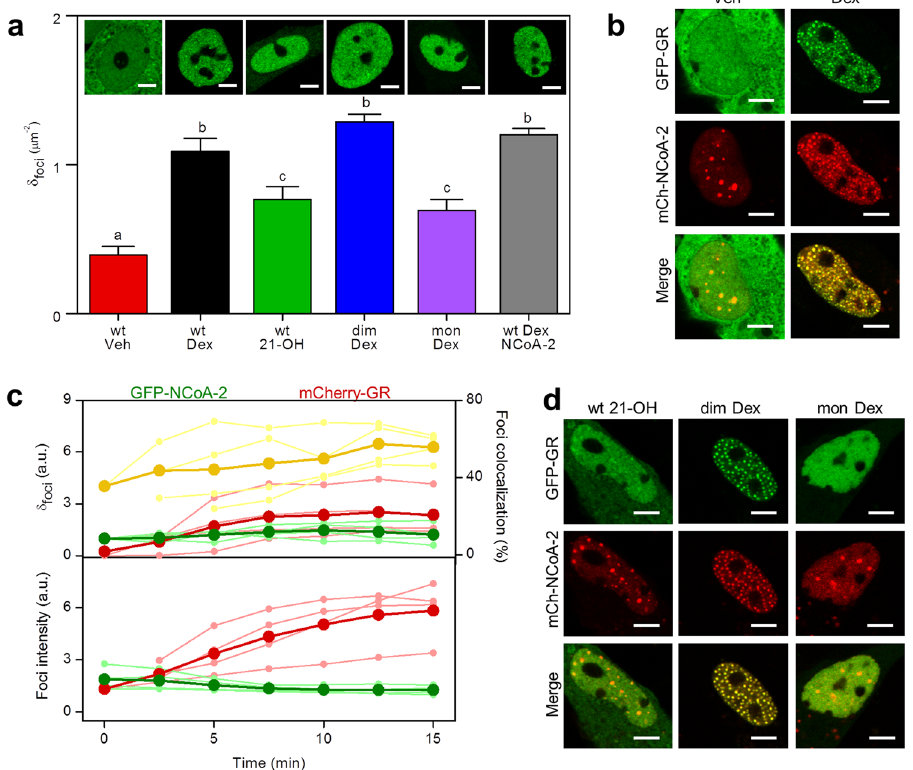
Figure 1. Activated GR and NCoA-2 redistribute to colocalized intranuclear foci. Subcellular distribution of GFP-GR and mCherry-NCoA-2 in BHK cells was analyzed upon hormone induction by using different imaging tools as indicated in Methods section. ( a ) Cells expressing GFP fused to the indicated GR variant (wild type, GRdim, GRmon) were treated with Dex, 21-OH or vehicle (Veh). NCoA-2 was co-expressed where indicated (Scale bar: 5 µ m). GR capability to form intranuclear foci was quantitatively analyzed by calculating the nuclear foci density (n = 15). Bars with the same superscript letters represent data not significantly different from each other (p < 0.05). ( b ) Subcellular distribution of GFP-GR and mCherry-NCoA-2 in untreated or Dex-stimulated cells (Scale bar: 5 µ m). ( c ) Analysis of time-lapse images of cells co-expressing GFP-NCoA-2 and mCherry-GR, within 15 min after Dex-stimulation. Different image-analyisis tools were used to calculate the relative foci density ( δ ) (upper panel); percentage of colocalized foci (upper panel, yellow line) and the relative mean intensity of foci (lower panel). Light curves represent single cell data to illustrate the cell-to-cell variability while dark curves correspond to mean values. ( d ) Representative images of cells expressing mCherry-NCoA-2 and GFP fused to the indicated GR variant (wild type, GRdim, GRmon) and treated with Dex, 21-OH or Veh (Scale bar: 5 µ